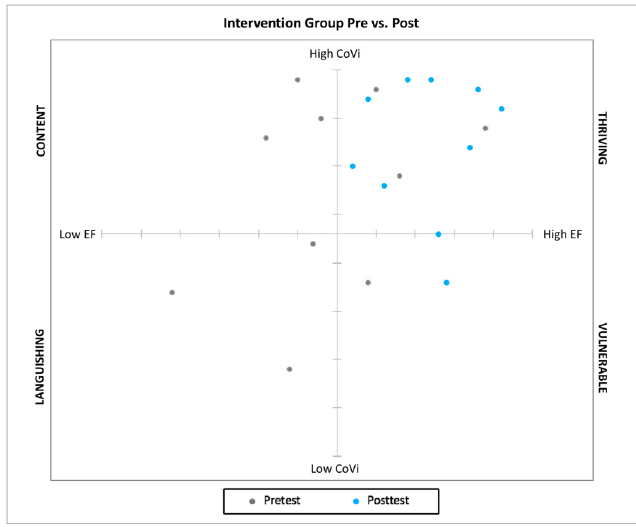
Figure 3. Intervention Group Student Profiles at Pretest and Posttest . EF = executive function; CoVi = student covitality. Map illustrating multidimensional student profiles according to the dual-factor model of school-based wellbeing measured at pretest (gray) and posttest (blue).